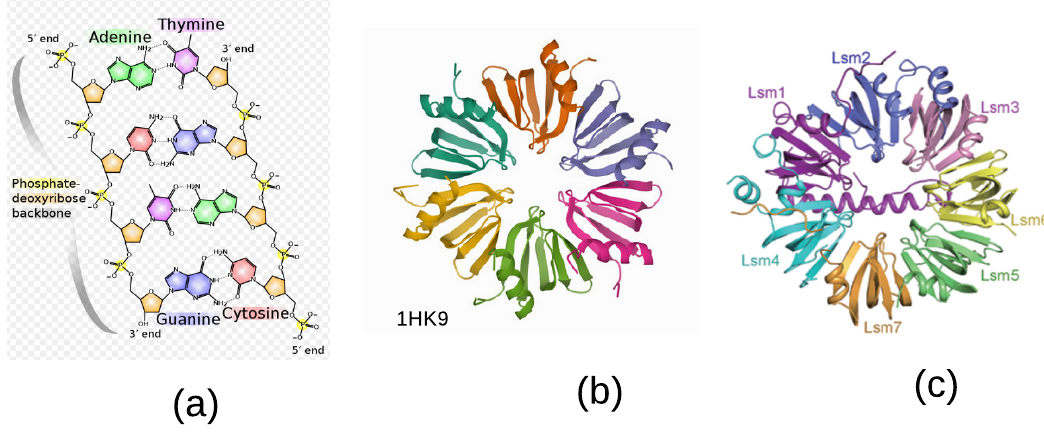
Figure 1. ( a ) Five-fold symmetry in the DNA, ( b ) six-fold symmetry in the LSM protein complex Hfq [4], ( c ) seven-fold symmetry of the Lsm1-7 complex in the spliceosome